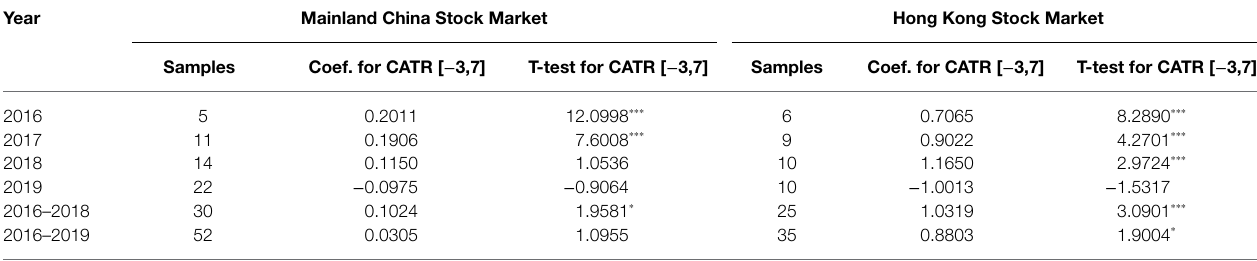
TABLE 6 | Robustness test results based on replacing stock price with trading